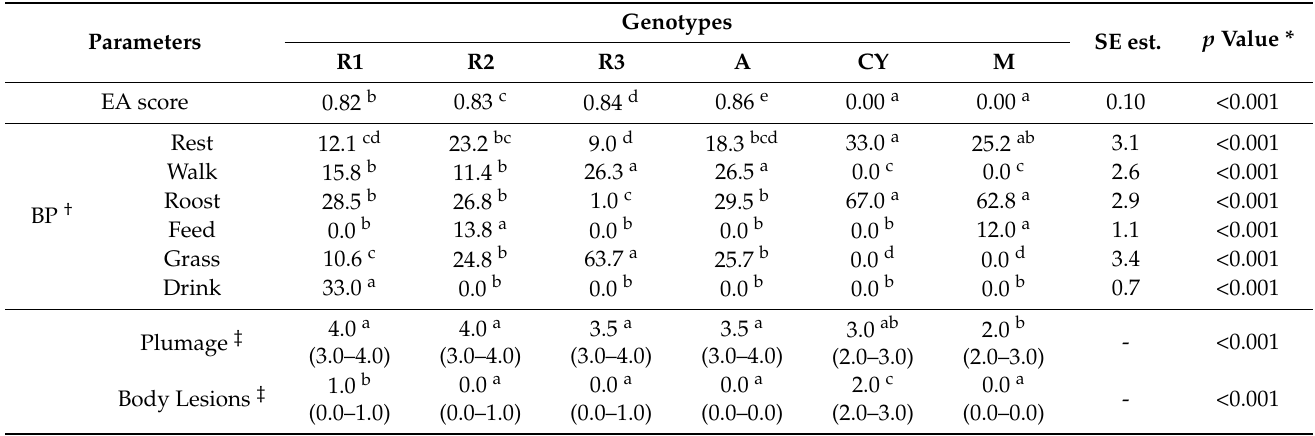
Table 2. Explorative attitude (EA, score), behavioral patterns (BPs, in percentage), and plumage and lesion scores (scale 0–4) expressed by the six genotypes studied.